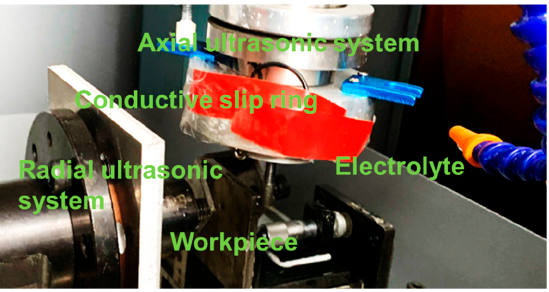
Figure 7. Partial machining experimental settings.